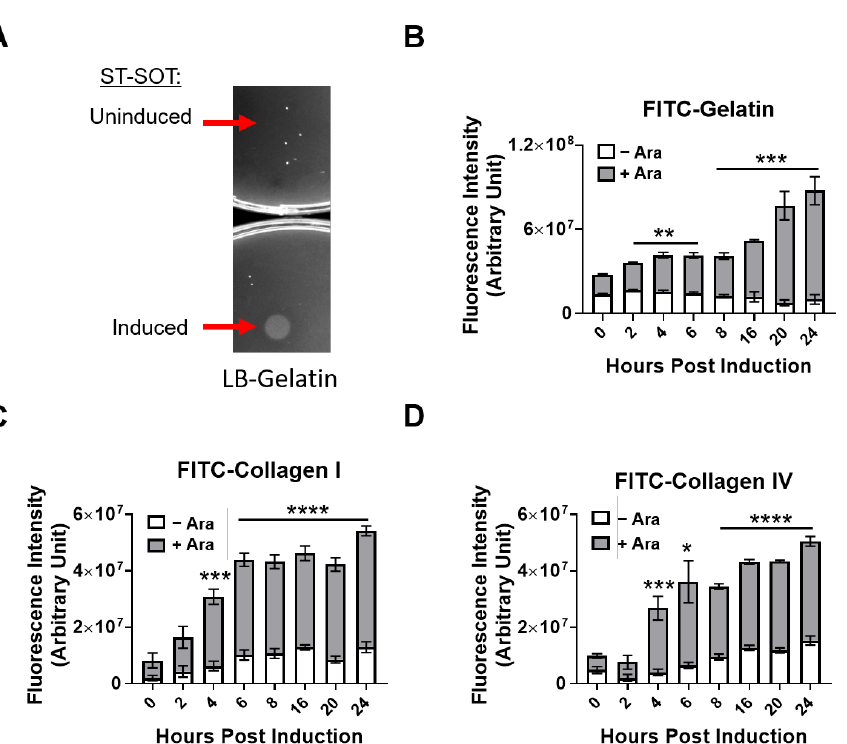
Figure 2. Hydrolytic collagenase activity of ST-SOT towards various substrates. ( A ) Uninduced or induced (2% L-arabinose) ST-SOT was incubated on LB-gelatin plates overnight (16 h) at 37 °C. Hydrolysis of gelatin in LB agar media is observed as opaque areas on LB-gelatin plates. Arrows indicate areas where uninduced or induced ST-SOT were spotted onto the plate. ( B ) Hydrolysis reactions were performed using uninduced or induced ST-SOT co-incubated with FITC-conjugated pig skin gelatin, bovine skin collagen type I ( C ) or human placenta collagen type IV ( D ) in 50 mM Tris-HCl (pH 8.0) containing 10 mM CaCl 2 at 37 °C. Enzyme activity was measured by monitoring fluorescence (FITC) (ex: 495 nm, em: 519 nm). Data are expressed as mean ± error of mean of three independent experiments. * p < 0.05, ** p < 0.01, *** p < 0.001, **** p < 0.0001, t -test.